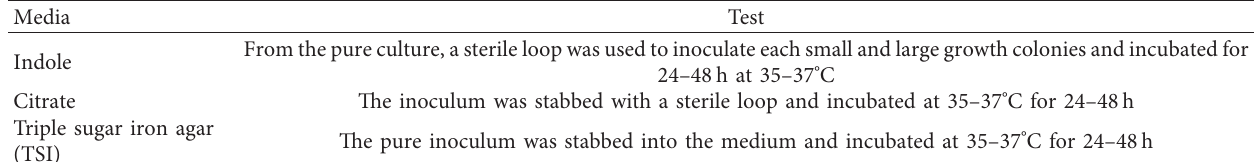
Table 1: Biochemical sensitivity test on selected